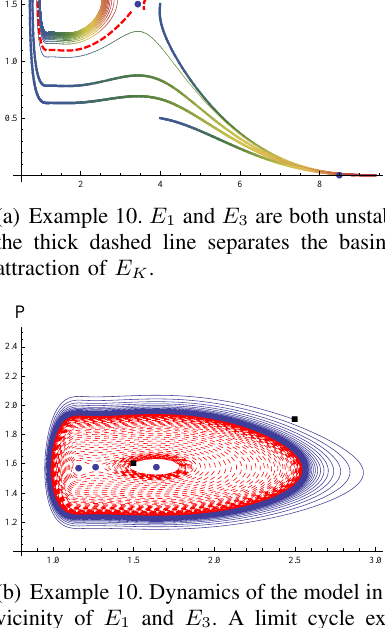
(b) Example 9. Dynamics of the model (4) in the vicinity of E 1 and E 3 . All trajectories tend to the stable equilibrium E 3 . Fig. 15. Dynamics of system (4) in the case of one stable and three ustable internal equilibrium points. Example 9.